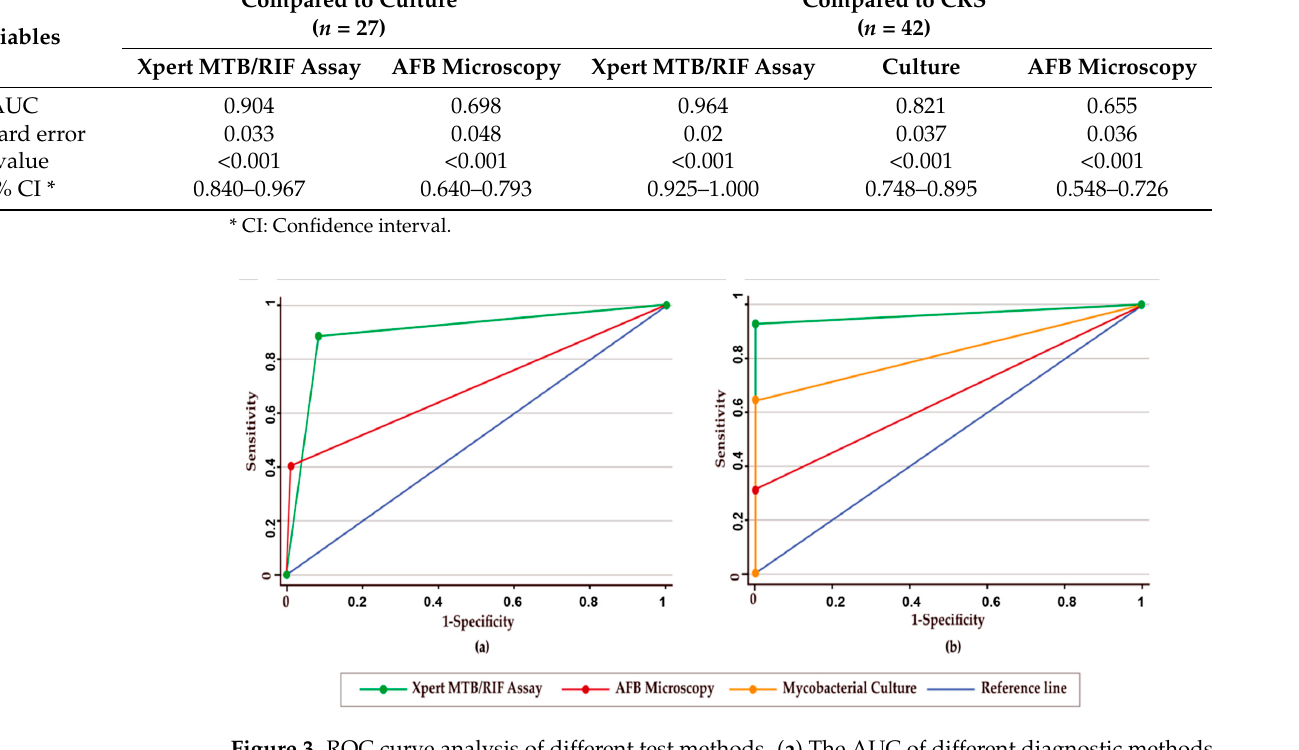
Figure 3. ROC curve analysis of different test methods. ( a ) The AUC of different diagnostic methods when compared to culture; ( b ) the AUC of different diagnostic methods when compared to CRS as the case group.